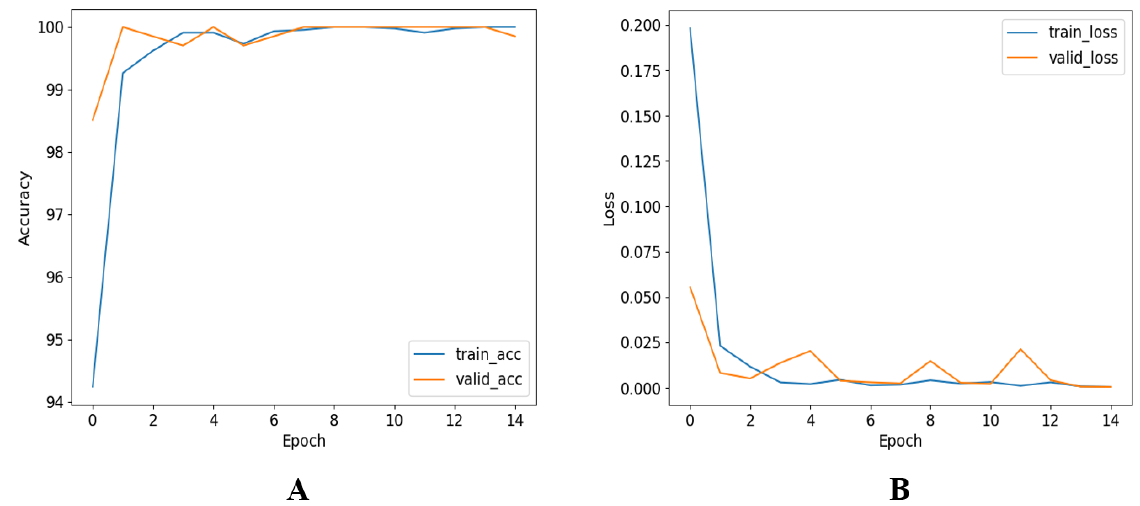
Figure 9. Training and validation ( A ) accuracy versus epoch and ( B ) losses versus epoch for the the best-performing trained CNN